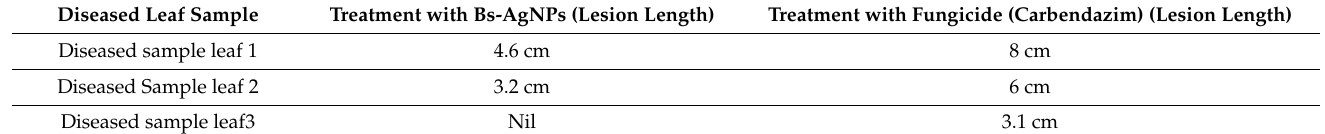
Table 6. Lesion length of the diseased leaf.